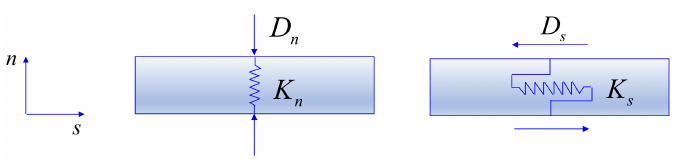
Figure 2. Representation of a joint